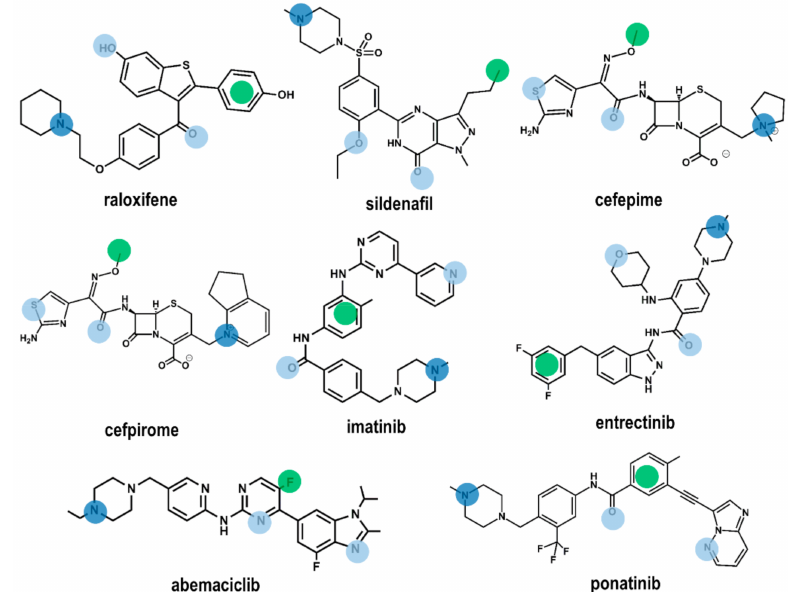
Figure 4. Chemical structures of the eight compounds identified by virtual screening of the DrugBank database. Color dots are drawn on top of the moieties responsible for fulfilling pharmacophore points P1–P4 according to the color code described in Figure